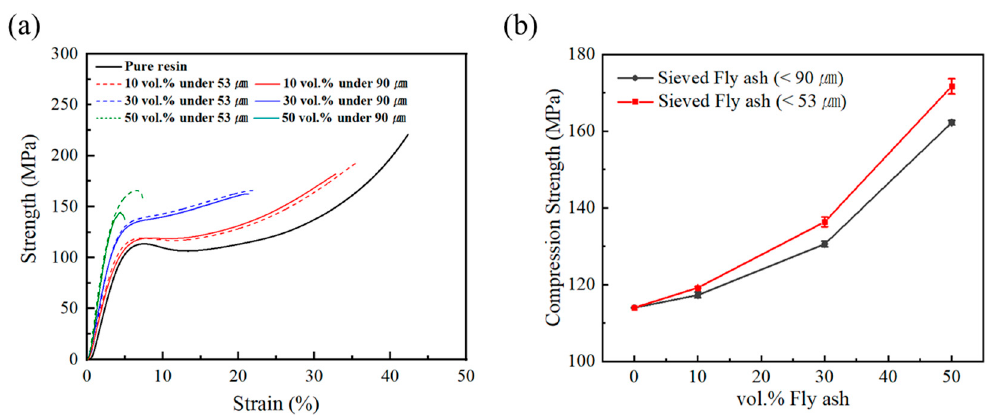
Figure 9. ( a ) Compressive stress–strain curves of composite containing less than 90 μ m, less than 53 μ m fly ash, ( b ) Compression strength of the fly ash/epoxy